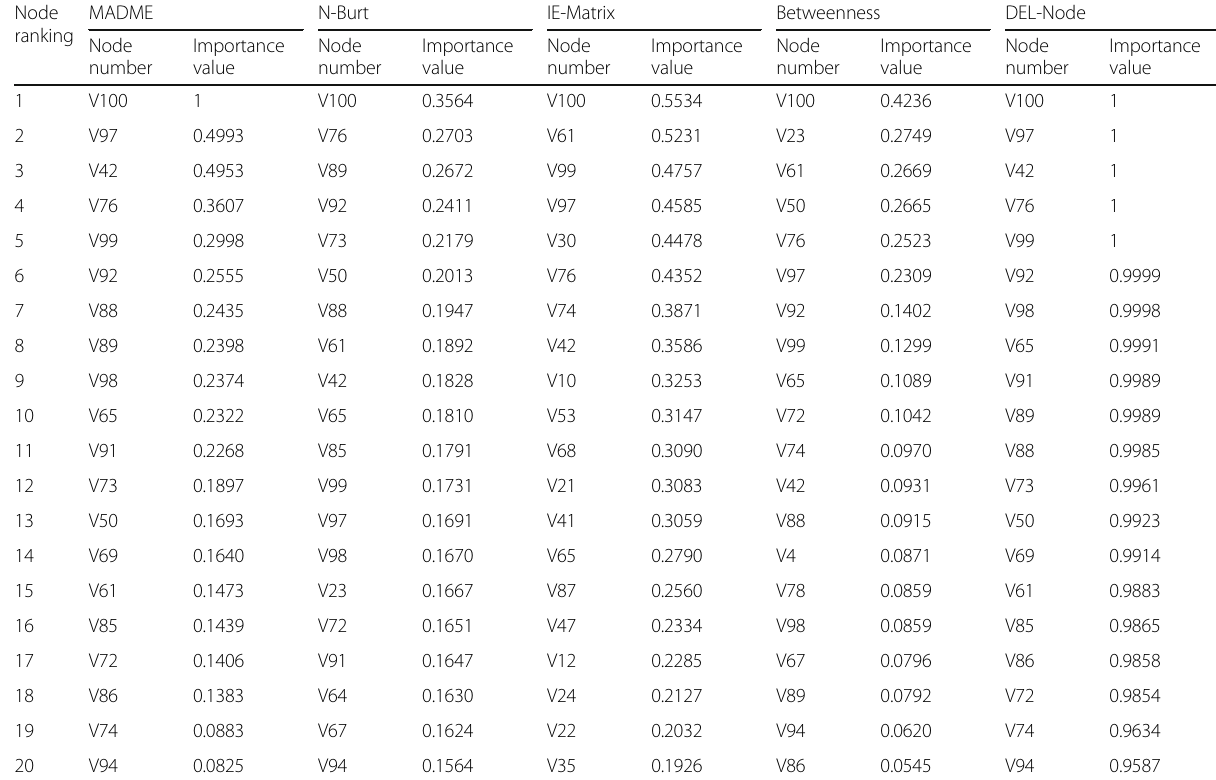
Table 3 Evaluation results of node